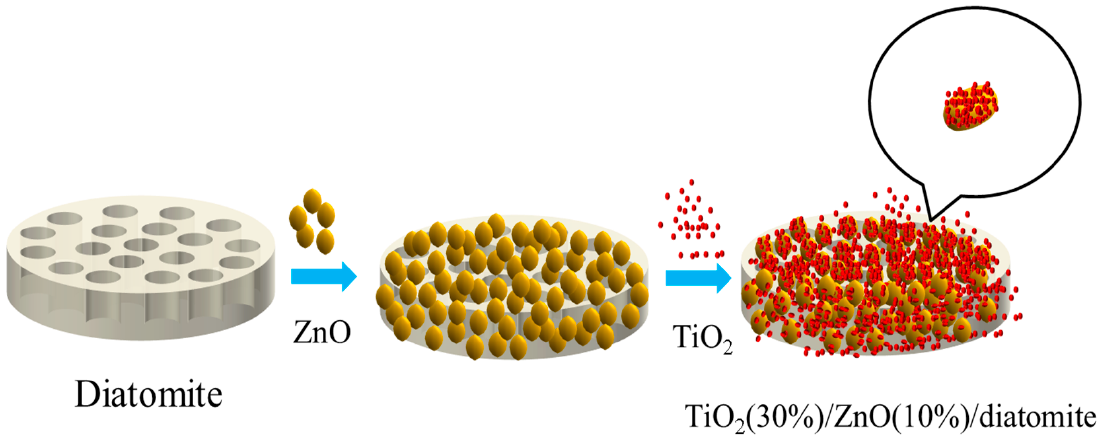
Figure 7. Schematic diagram of the formation of TiO 2 (30%)/ZnO(10%)/diatomite.